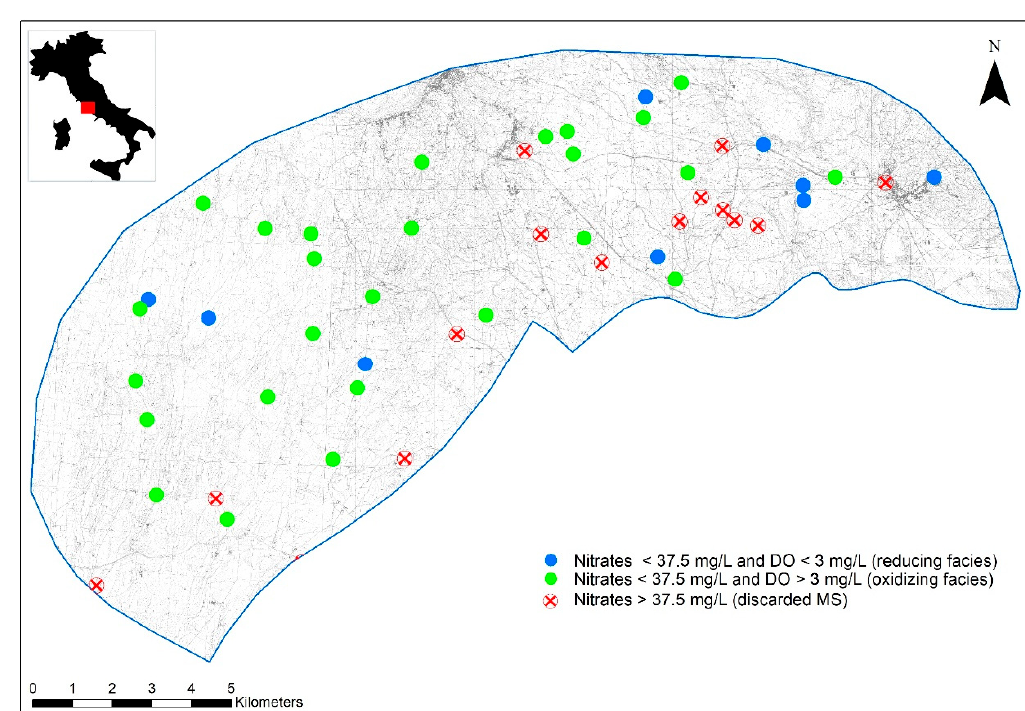
Figure 5. Redox facies subdivision based on dissolved oxygen concentration (DO) concentration and preselected MSs. Table 2. Pearson ( r ) and Spearman ( r s ) correlation coefficients for the redox parameters and the investigated elements. Statistically significant values in bold ( α =